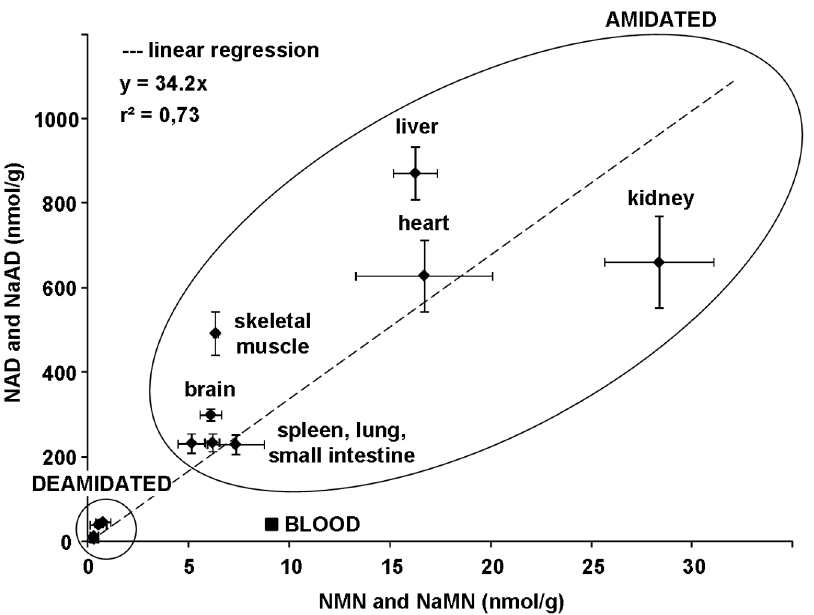
Figure 5. Correlation between the physiological levels of products (NAD or NaAD) and substrates (NMN or NaMN) of the NMNAT-catalyzed reaction in different mouse tissues. Average values ¡ standard errors are those depicted in Figure 4. The ‘‘AMIDATED’’ refers to grouped NAD and NMN levels in the indicated tissues; the group ‘‘DEAMIDATED’’ refers to levels of NaAD and NaMN (smaller circle) in the same tissues (not detailed). The linear relationship in different tissues between the steady-state levels of NAD and NaAD relative to NMN and NaMN, respectively, is highlighted. The ‘‘outlier’’ square symbol ( & ) represents blood, where diverging values were observed compared to all other examined